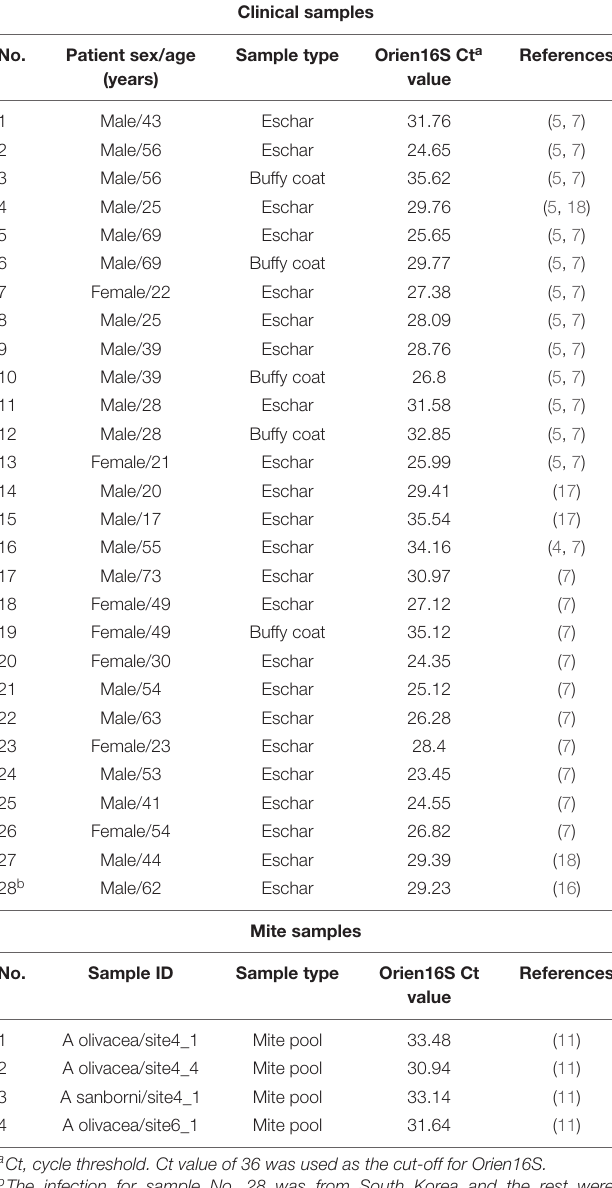
TABLE 3 | Amplification results (Ct values) of new Orien16S qPCR assay in specimens from human scrub typhus cases and mite pools from Chiloé Island. Clinical